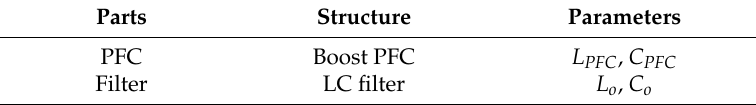
Table 1. Main components of the input and output